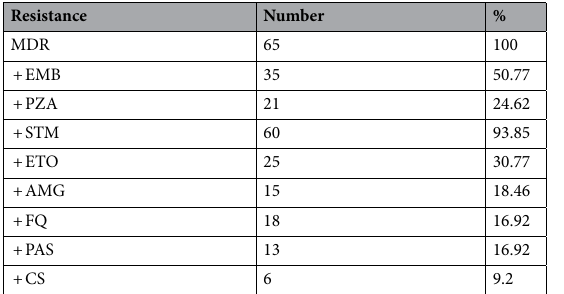
Table 1. Overview of additional phenotypic resistance of MDR strains to first-line and second-line antituberculosis drugs. EMB ethambutol, PZA pyrazinamide, STM streptomycin, AMG aminoglycosides